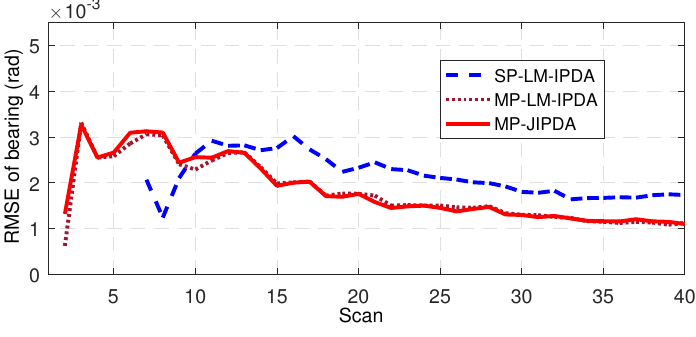
Figure 10. RMSE of bearing for Target 5.